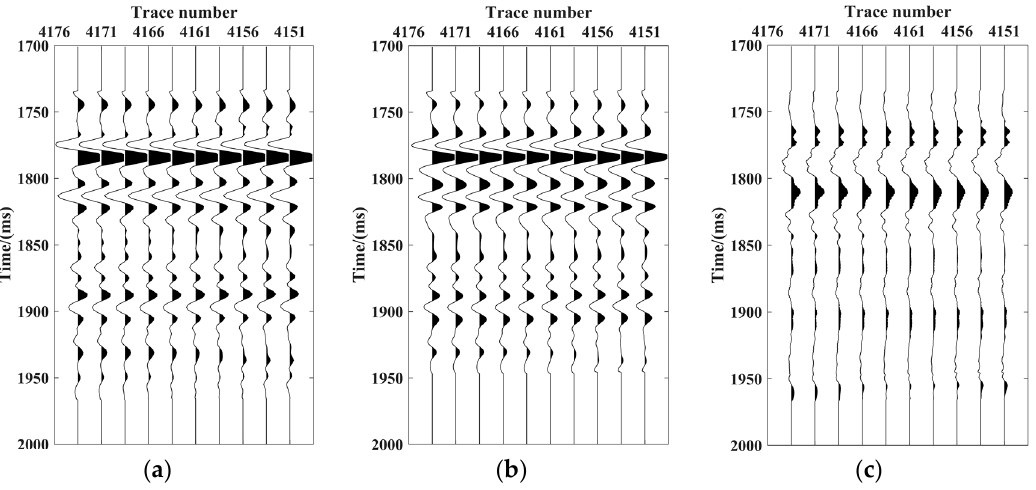
Figure 10. Part of seismic data. ( a ) Field data; ( b ) GMHDD; ( c ) Error between field data with GMHDD.